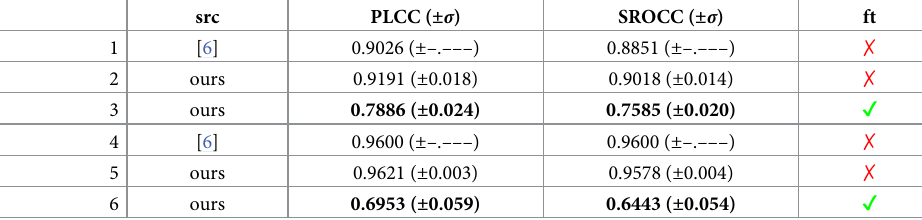
Table 1. Performance results of DeepBIQ on LIVE-in-the-wild (rows 1-3) and TID2013 (rows 4-6) according to [6], as well as our own reimplementation of the approach as described in the paper. The last column designates whether fine-tuning (column ‘ft’) was performed correctly (green checkmark), or with data leakage Case I (red cross). The numbers in bold font in lines 3 and 6 give the true performance of DeepBIQ, much below the claimed 0.90/0.89 PLCC/SROCC for LIVE-in-the-wild and 0.96 PLCC and SROCC for TID2013. src PLCC ( ± σ